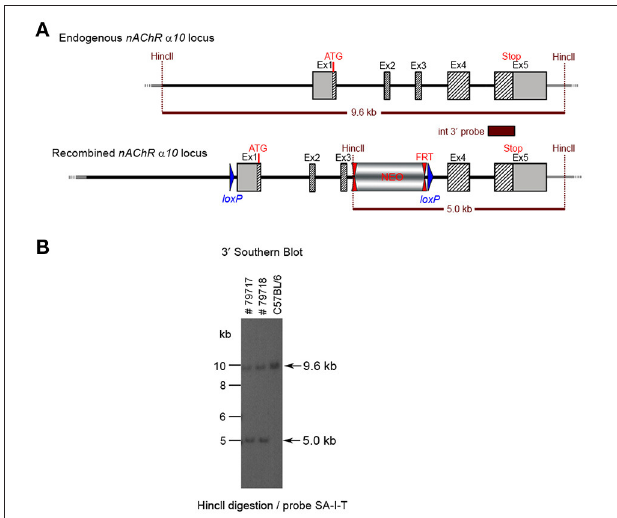
FIGURE 8 | (A) The schemata for the endogenous and recombined α 9 nAChR loci and the Cre-mediated excised locus. (B) The Southern blot validation of the α 10 Heterozygous F1 or N2 generation. The genotype of the pups derived from the F1 or N2 breeding with Cre deleter mice was determined by PCR as described in the Methods section. To confirm the results of the PCR, the genomic DNA of eight animals: WT (#29210, #29212), recombined (#29211, #38053, #38057) and knockout (#29213, #38365, #38370). HincII digested DNAs were blotted on nylon membrane and hybridized with the internal 3 ′ probe (SA-I-T). The constitutive knockout line was established from #38370. The conditional knockout line was established from